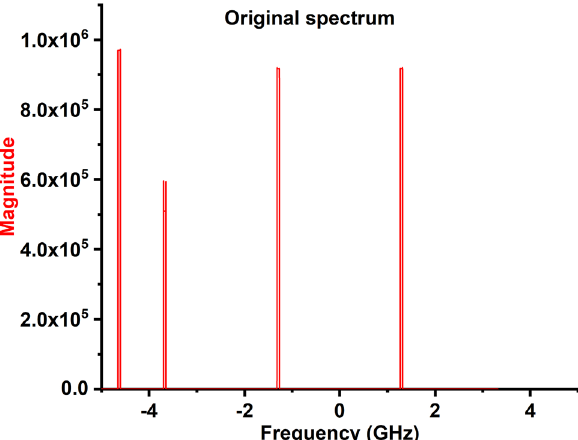
Figure 23. Detected 3.8 GHz spectrum after processed in MATLAB. (Matlab V2021).